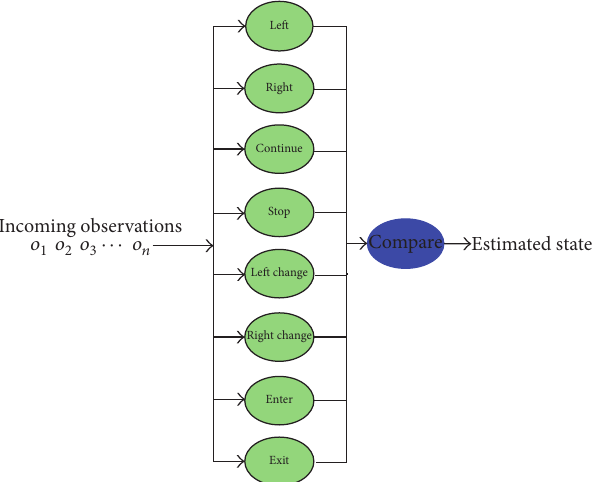
Figure 1: Graphical representation of possible event metastates and incoming CSS state estimates. Output estimated state corresponds to HSS+HMM state estimate.